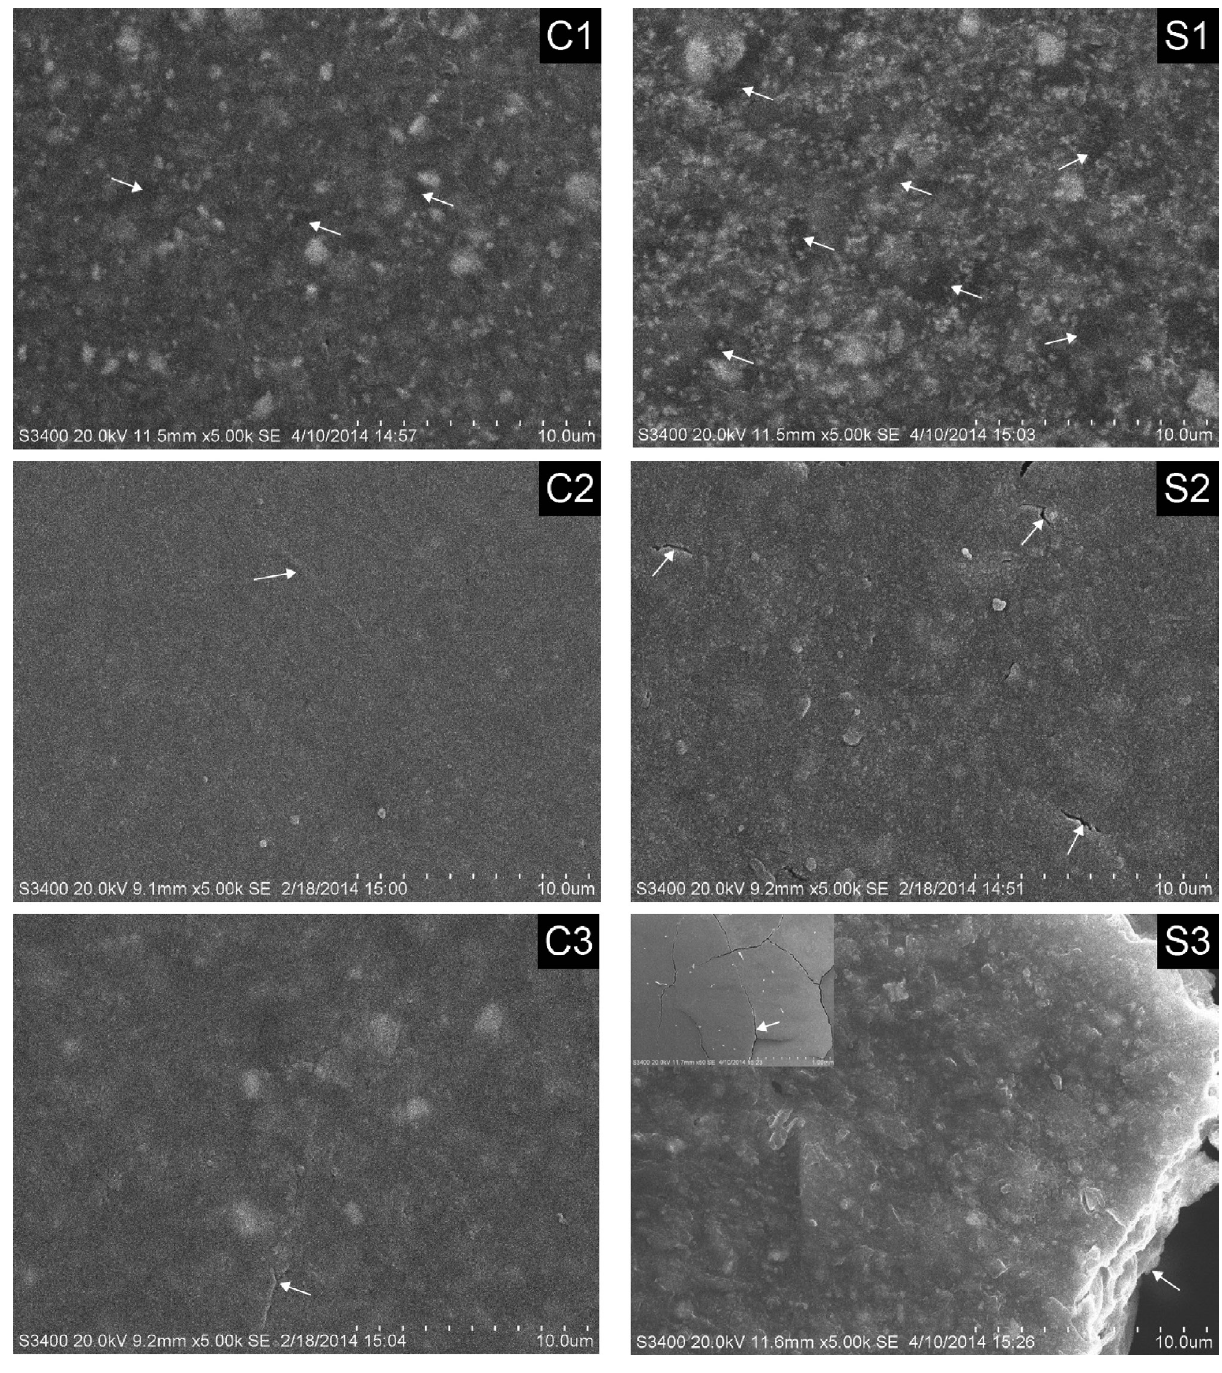
Figure 3- Scanning electron microscopy (SEM) photographs of all resin cements, after 18 months of water immersion. The exposed fillers, cracks, and voids can be observed in each photograph and are marked with white